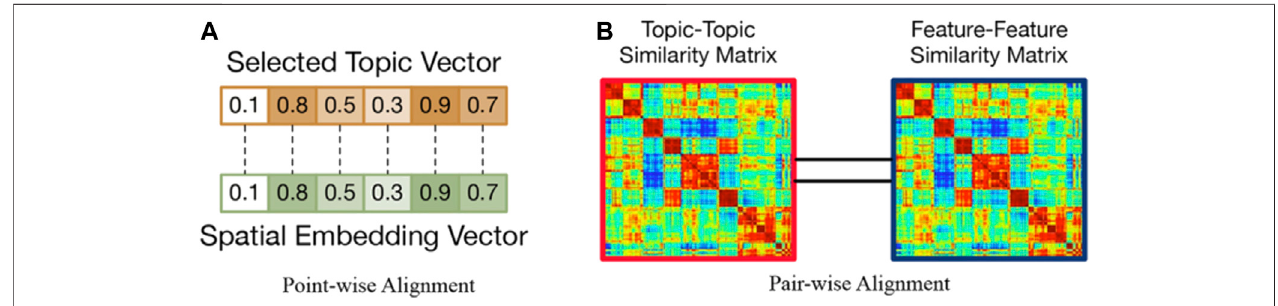
FIGURE 4 | Two kinds of space